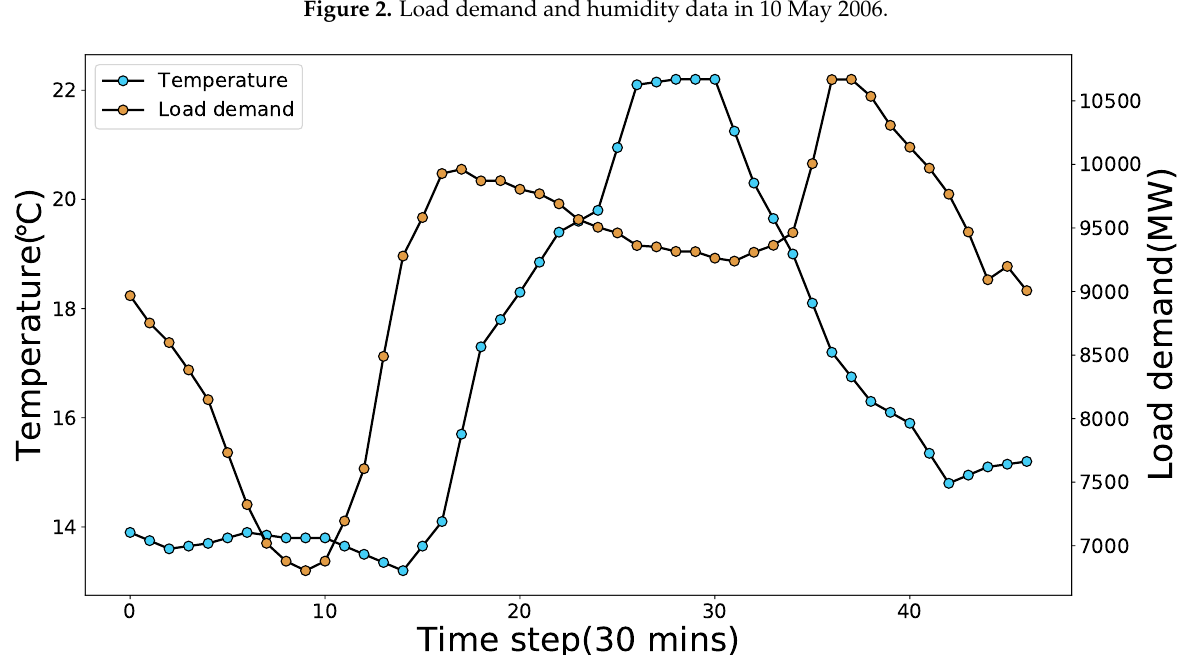
Figure 3. Load demand and temperature data in 10 May